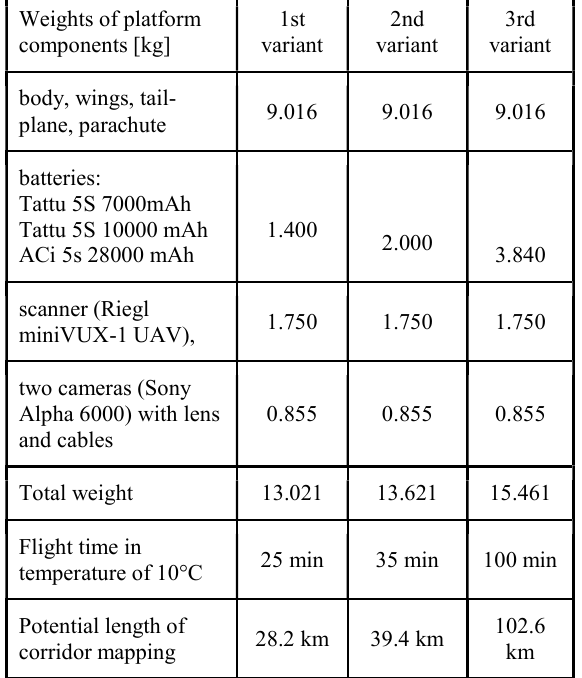
Table 1. Calculations of flight possibilities for the NEO3 platform with different